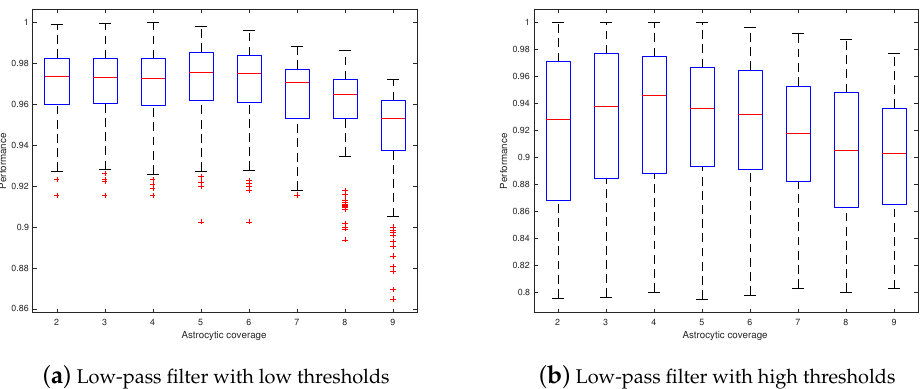
Figure 9. Short-term memory performance subject to low-pass filter with low and high thresh- olds. The horizontal axis denotes the size of astrocytic coverage and the vertical axis denotes the performance score C p . Both figures demonstrate a decline in performance from l =